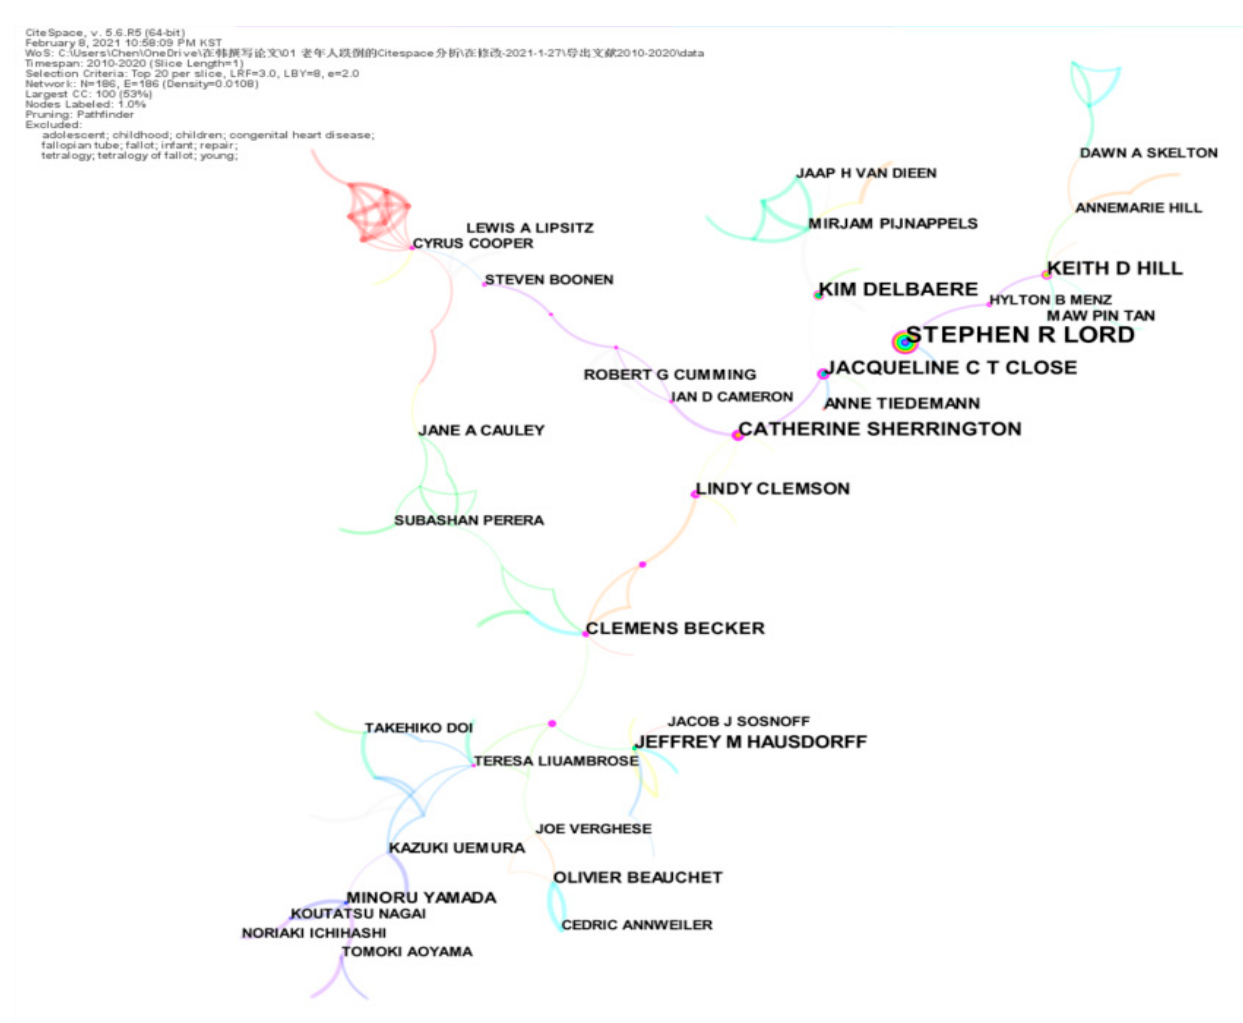
Figure 3. Co-authorship network (2010–2020). The color of the line represents the time the co-authors worked together. The larger the node diameter, the more papers the author has collaborated to publish. The thicker the line between the nodes, the closer the cooperation between the two authors.